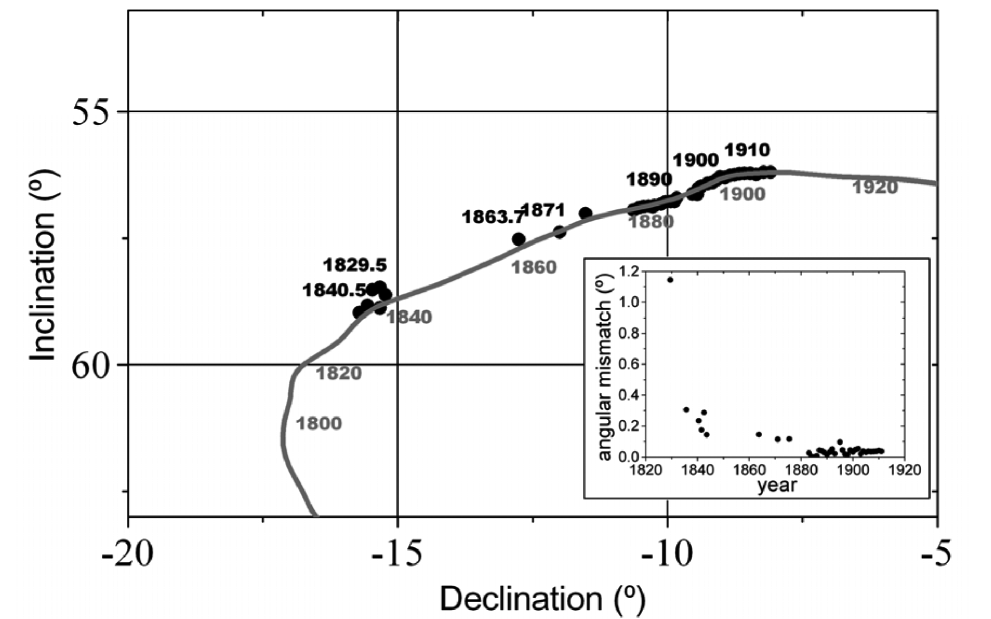
Fig. 2 . Comparison between the Neapolitan geomagnetic data, circles, from the Historical Italian Geomagnet- ic Data Catalogue (Cafarella et al. , 1992a) and the GUFM1 (Jackson et al. , 2000) field model, grey line, in Naples. Inset: angular mismatch between data from the Catalogue and the corresponding values computed us- ing GUFM1